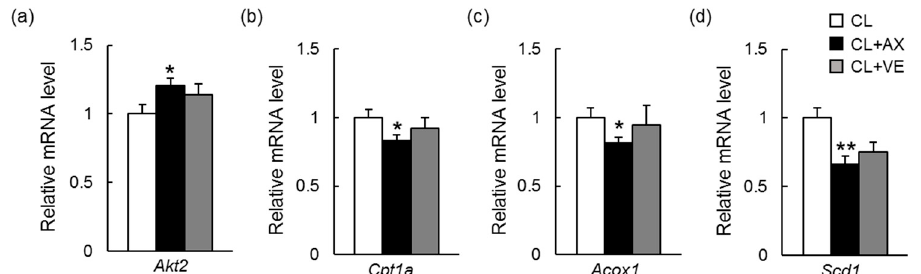
Figure 3. Hepatic mRNA expression of EIF2 signaling-, mitochondrial dysfuction-, peroxisome proliferator-activated receptor α (PPARA)-, and PPAR δ (PPARD)-related molecules assessed by quantitative real-time PCR (qPCR). ( a ) EIF2 signaling-related molecule, Akt2 mRNA expression in the liver of mice with CL diet-induced nonalcoholic steatohepatitis; ( b ) Mitochondrial dysfuction-related molecule, Cpt1a mRNA expression in the liver of mice; ( c ) PPAR α -related molecule, Acox1 mRNA expression in the liver of mice; ( d ) PPAR δ -related molecule, Scd1 mRNA expression in the liver of mice. * p < 0.05, ** p < 0.01 vs. the CL diet.